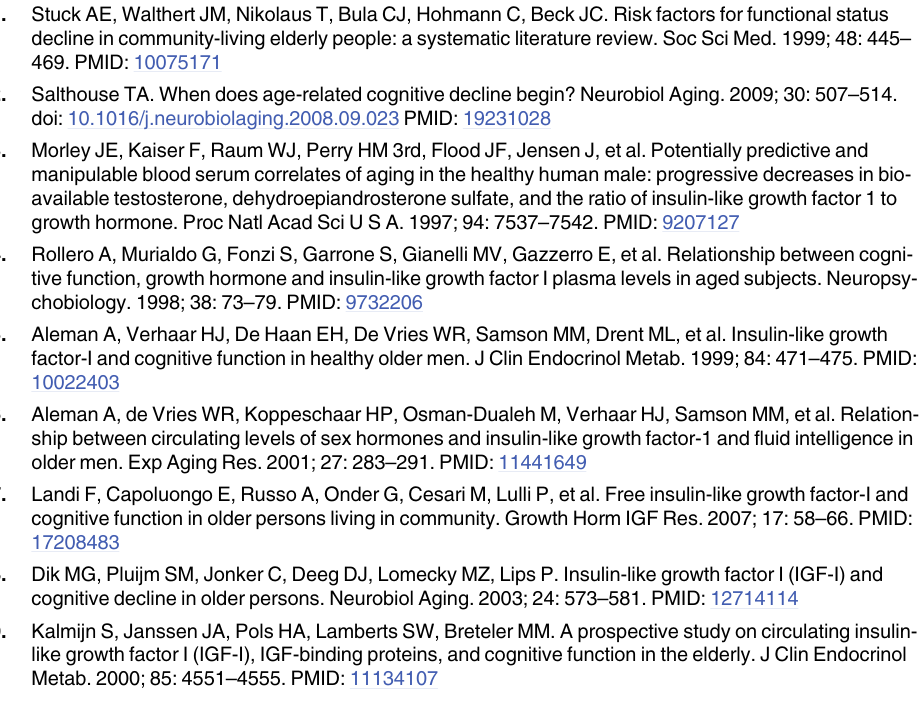
S1 Table. Baseline characteristics and cognitive performance of complete sample (n = 400) according to quintiles of IGF-1. S2 Table. B (95% CI) for association between baseline cognitive scores and quintiles of IGF-1. S3 Table. Associations between follow-up cognitive scores and quintiles of IGF-1 in com- plete case dataset. S4 Table. B (95% CI) for association between cognitive scores at follow-up, and at baseline with quintiles of IGF-1, separated by age classes. S5 Table. B (95% CI) for association between cognitive scores and serum levels of IGF-1. S6 Table. B (95% CI) for association between follow-up cognitive scores and quartiles of IGF-1 in the imputed